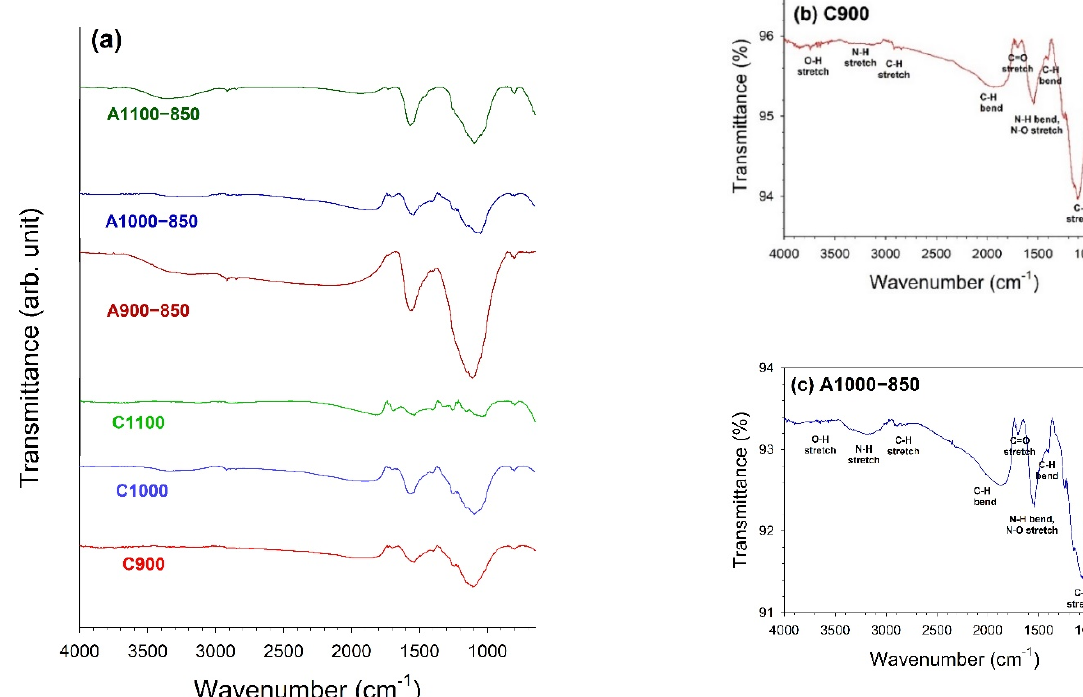
Figure 2. The FTIR spectra of the samples. ( a ) All samples, ( b ) C900, ( c ) A1000 − 850. Table 2. Results of the fits of the XPS C 1s region, values given in at.% (percent of total intensity). Binding Energy (eV) Type